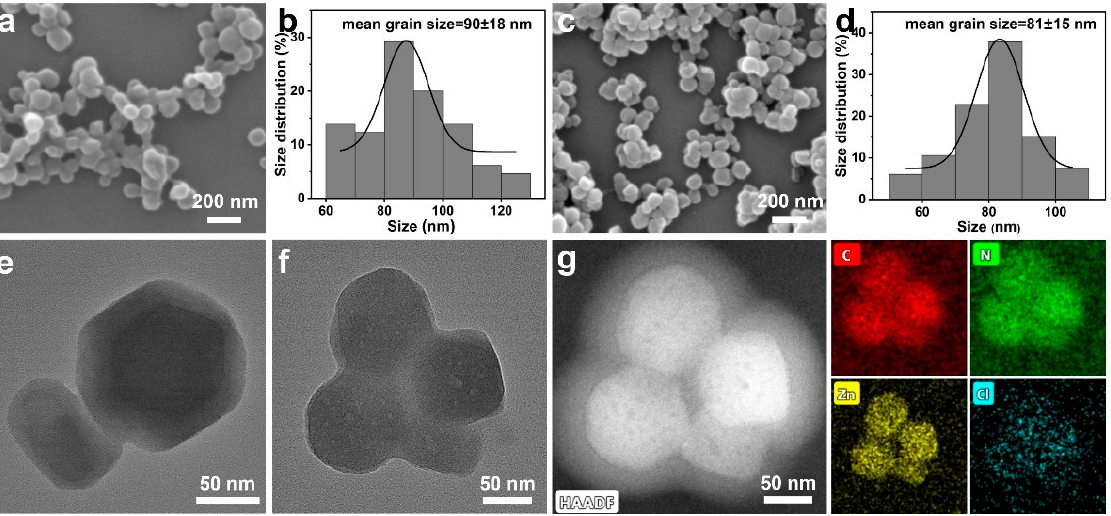
Figure 1. SEM images and size distributions of ( a , b ) ZIF-8 and ( c , d ) V@Z particles; TEM images of ( e ) ZIF-8 and ( f ) V@Z particles; ( g ) Elemental mapping of V@Z particles.